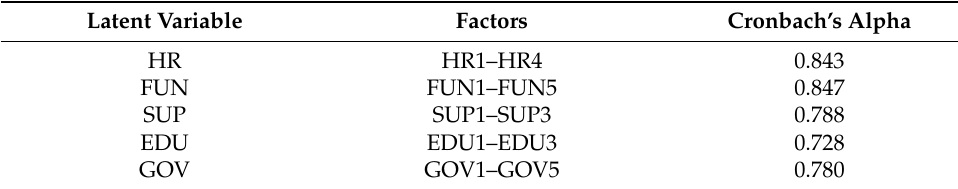
Table 8. Cronbach’s alpha values for each latent variable .